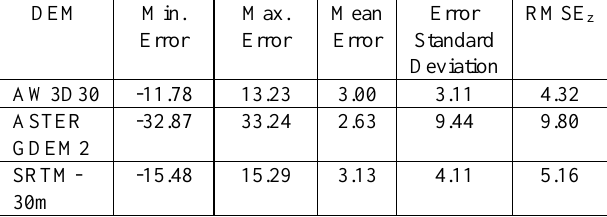
Table 2. Error statistics (in meters) generated from the vertical accuracy assessment of the DEMs using 2,076 ground control points. All values are in meters